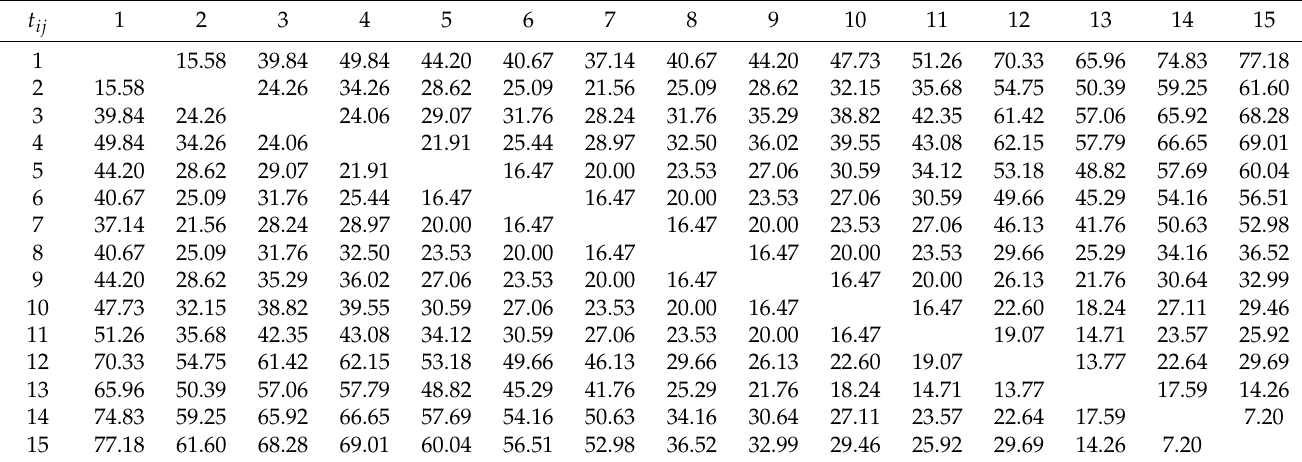
Figure 1. Layout of a real store with numbers corresponding to areas containing products of differ- ent categories . Table 1. Approximate travel time (s) between different zones in the reference